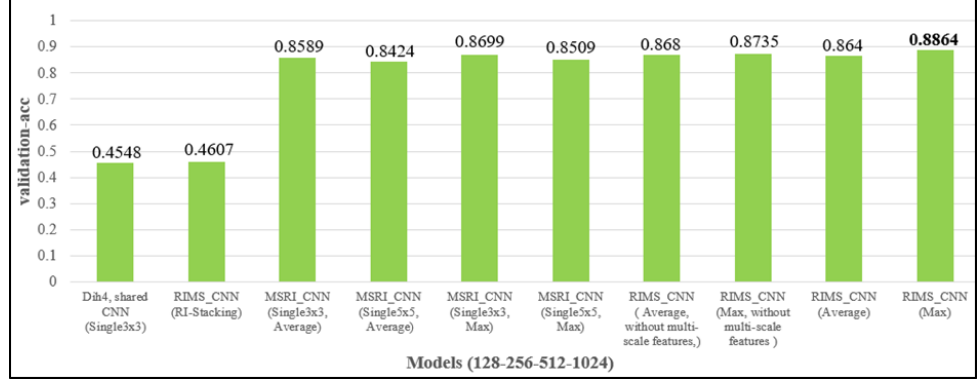
Figure 26. Evaluating different feature-extracting structures on the fixed-angle rotated CIFAR-10.